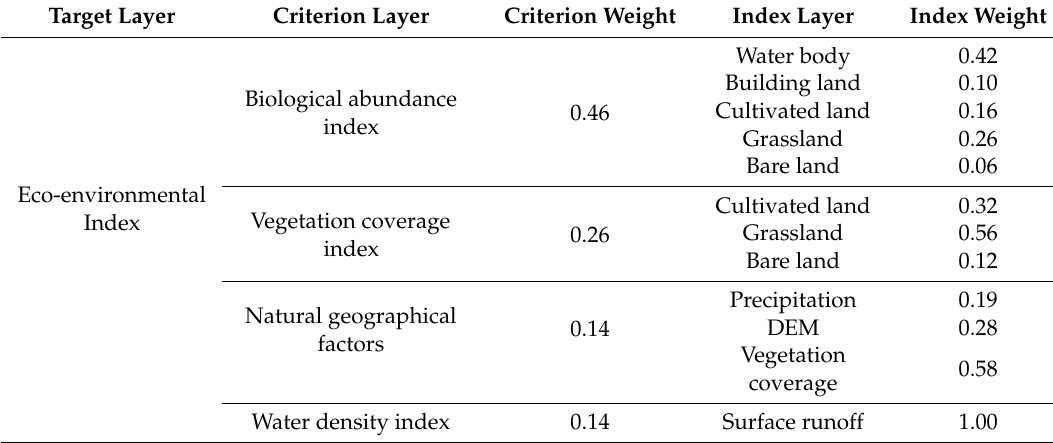
Table 7. Evaluation index